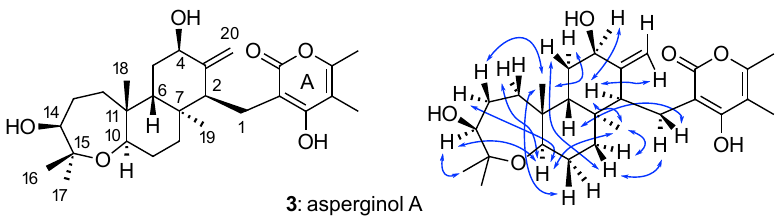
Figure 5. Asperginol A ( 3 ) and the 15 NOEs (in blue) included in the structural elucidation. W EB C OCON uses the force field total energy of the MD- or DG-generated conformation to rank the suggested constitution. The ranking for the correct constitution did not change